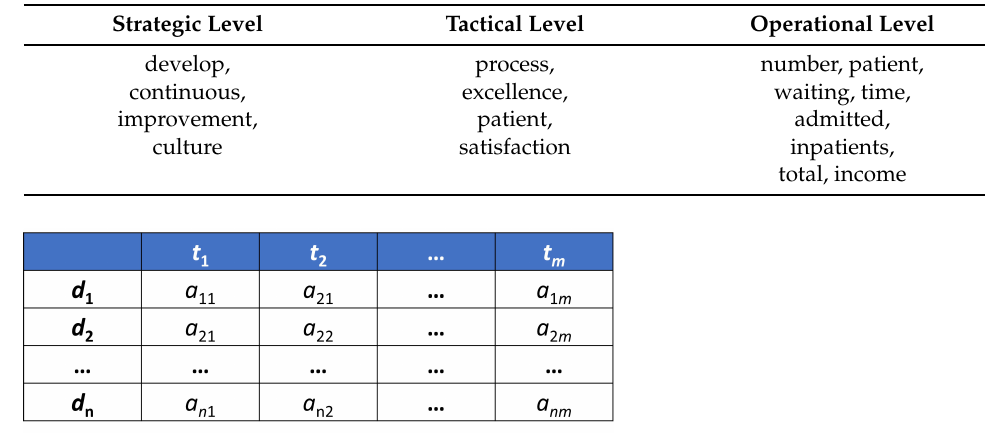
Figure 4. Illustration of the feature extraction using BoW